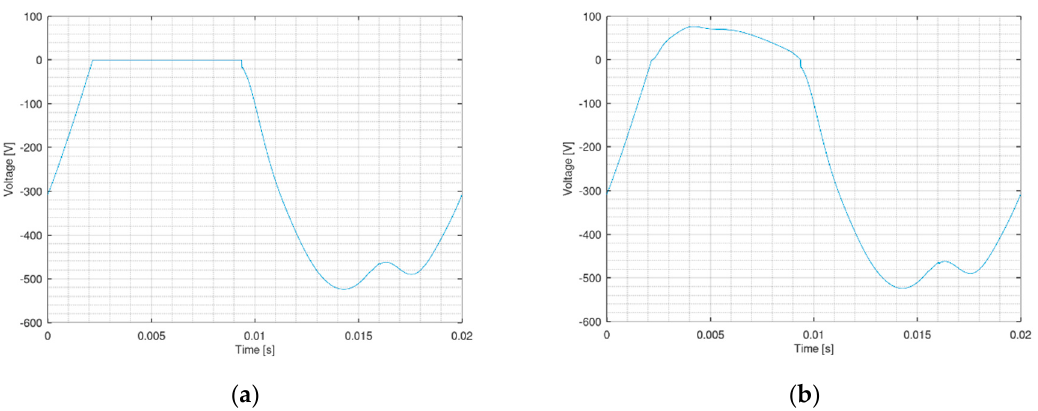
Figure 12. Voltages in the time domain: ( a ) of the equivalent source emf and ( b ) across the nonlinear.